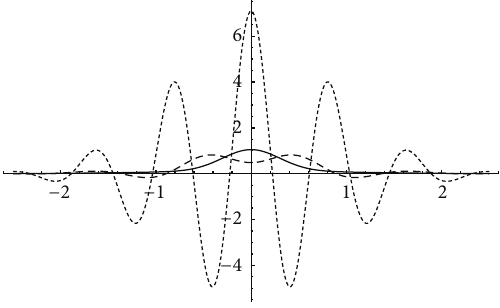
Figure 1: Gram-Charlier approximations to the density 𝑔 0.3 (𝑥) (solid line) when 𝑞 = 1/𝜎 0.3 ≐ 1.66 , resulting in 𝑐 1 = 𝑐 2 = 0 . The curve with long dashes is the order 10 approximation, and the one with short dashes is the order 20 approximation.